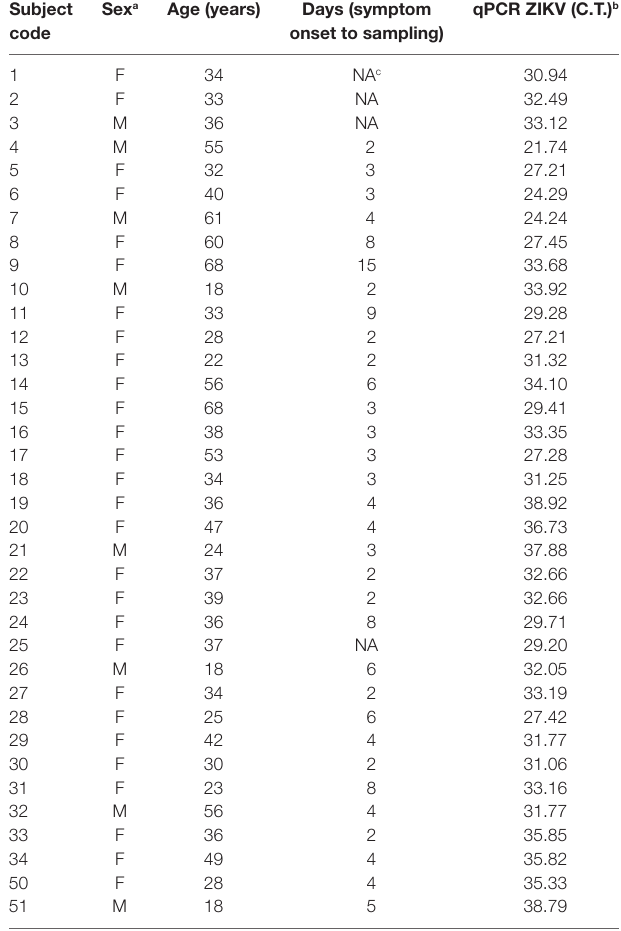
Table 1 | Characteristics of Zika virus (ZIKV)­infected